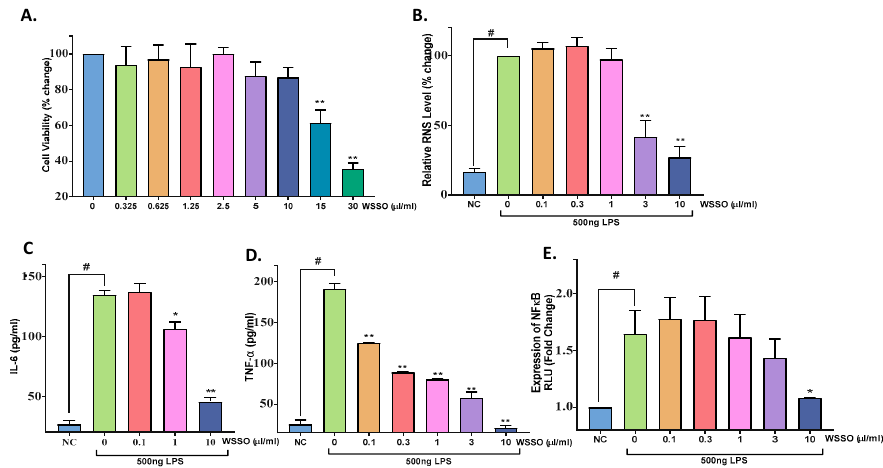
Figure 9. WSSO reduced total RNS in RAW264.7 cells and inhibits pro-inflammatory cytokines